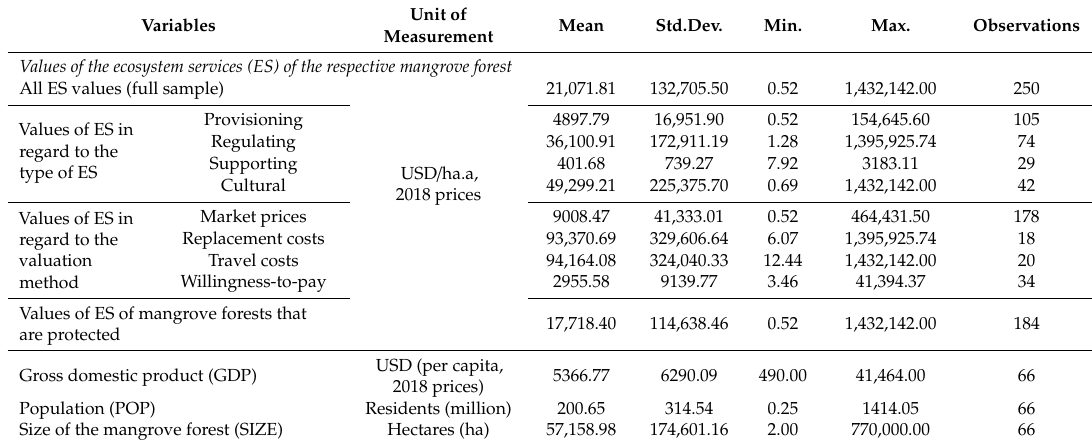
Table 3. Descriptive statistics of the values of ecosystem services (ES) of mangrove forests. Unit of Mean Std.Dev. Min. Max. Variables Measurement